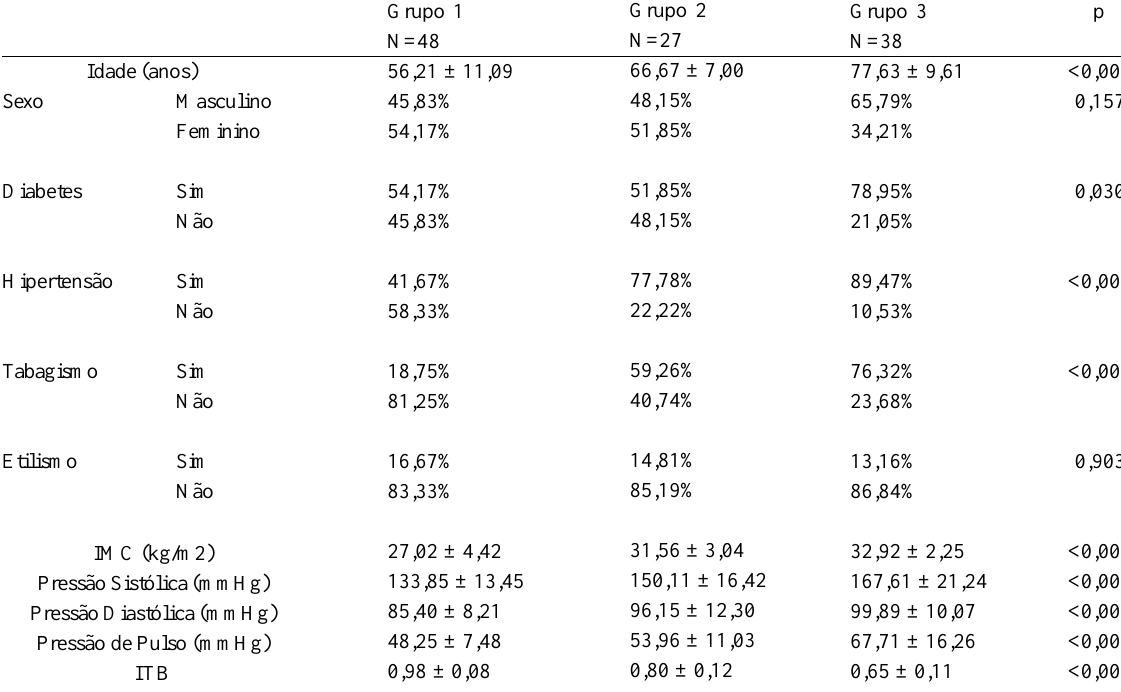
Grupo 1: ausência de lesão coronariana. Grupo 2: doença obstrutiva leve a moderada (estenose < 70%). Grupo 3: doença obstrutiva grave (lesão > 70%). ITB - Índice Tornozelo-braço.IMC - Índice de Massa